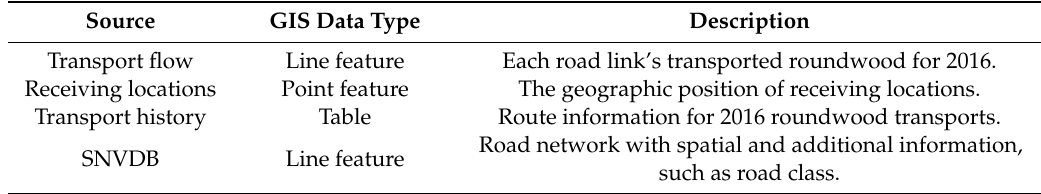
Table 2. Type of input data used in the study. All data delivered by Skogforsk and presented in the SWEREF99 coordinate system.